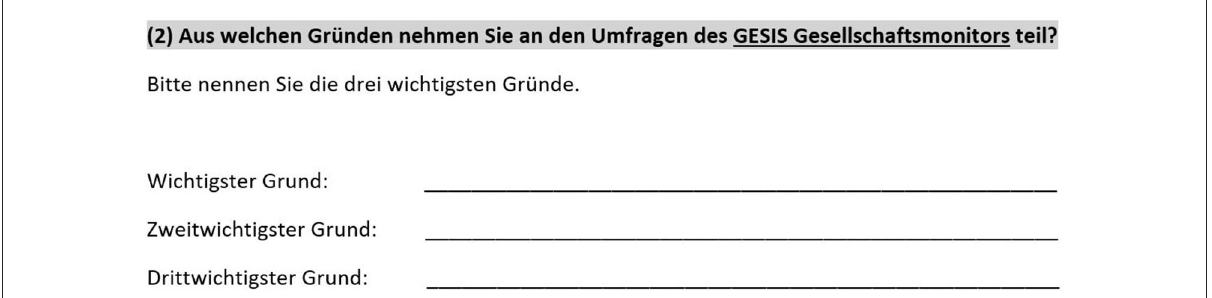
FIGURE1 Approximate design of the GESIS Panel questionnaire, mail survey, wave bf, recreated by the authors. Translation reads: “ (2) For what reasons do you participate in the surveys of the GESIS GesellschaftsMonitor? Please name the three most important reasons. Most important reason: …, Second most important reason: …Third most important reason: ….”